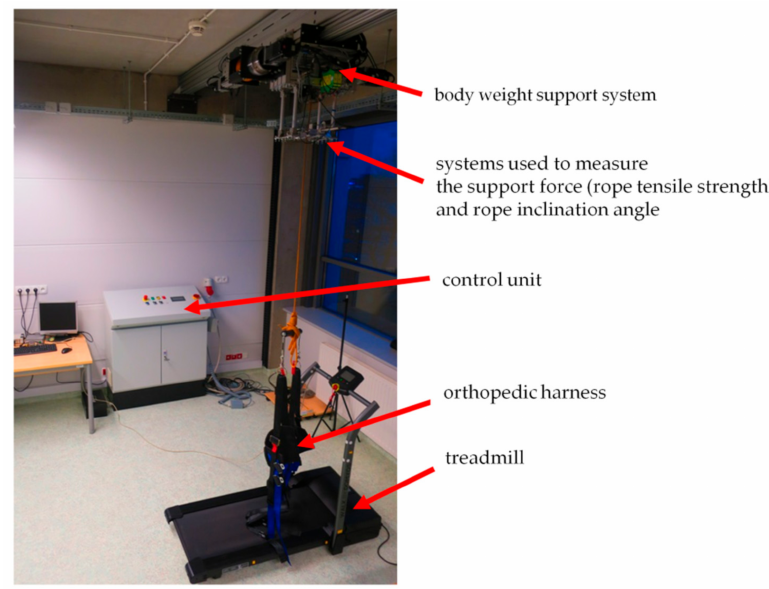
Figure 1. Mechatronic device for gait